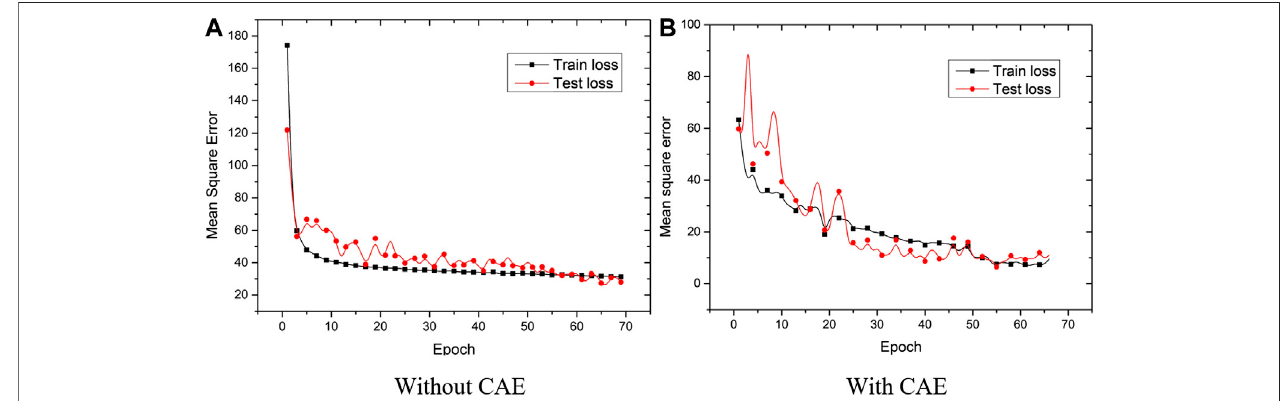
FIGURE 6 | Training and testing curves with or without CAE.